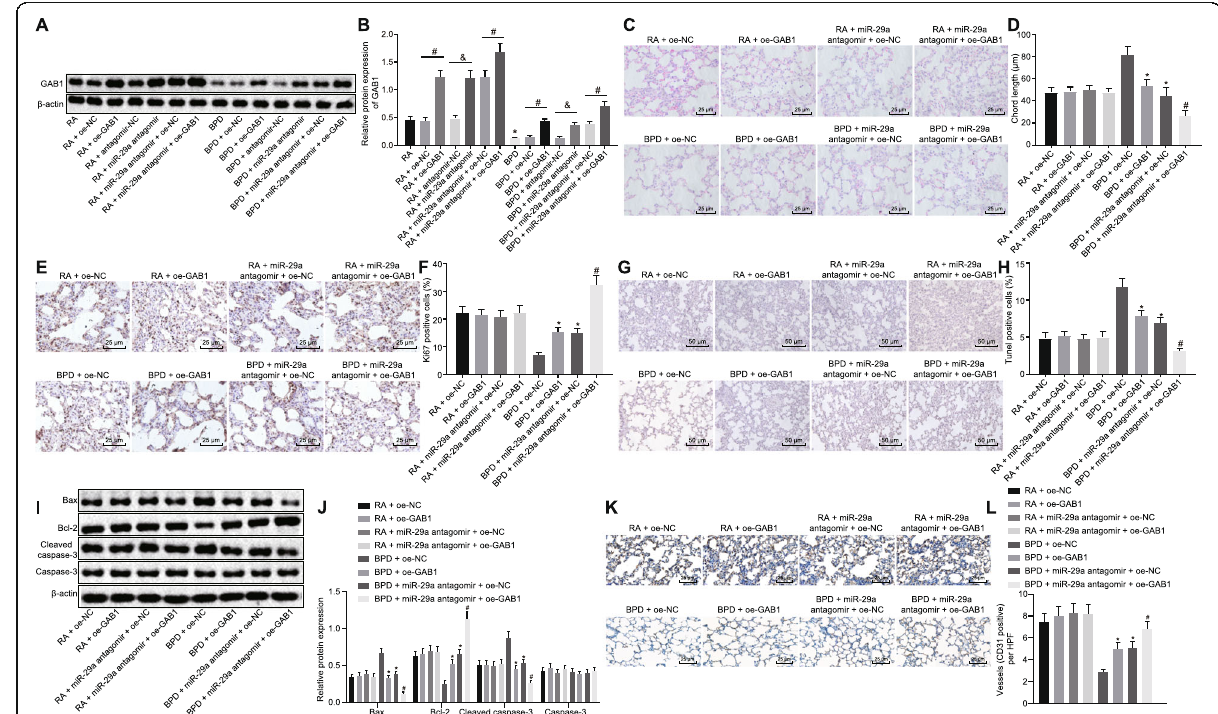
Fig. 4 Upregulation of GAB1 ameliorates BPD in neonatal mice. A&B, Western blot analysis of GAB1 protein in lung tissues of each group. * p < 0.05 vs. neonatal mice under RA exposure (the RA group). # p < 0.05 vs. neonatal mice with hyperoxia-induced BPD receiving oe-NC vector injection (the BPD + oe-NC group). & p < 0.05 vs. neonatal mice with hyperoxia-induced BPD receiving antagomir-NC injection (the BPD + antagomir-NC group). C, HE staining analysis of lung tissues in each group (× 400). D, Alveolar chord length of lung tissues in each group. E&F, Positive expression level of Ki67 in lung tissues of each group determined by immunohistochemistry (× 400). G&H, Cell apoptosis in lung tissues of each group assessed by TUNEL staining (× 200). I&J, Western blot analysis of apoptosis-related proteins (Bax, Caspase-3 and Bcl-2) in lung tissues of each group. K&L, Positive expression rate of CD31 protein in lung tissues of each group determined by immunohistochemistry (× 400). In panel C-L, * p < 0.05 vs. neonatal mice with hyperoxia-induced BPD receiving oe-NC vector injection (the BPD + oe-NC group). # p < 0.05 vs. neonatal mice with hyperoxia-induced BPD receiving an injection of antagomir-NC combined with oe-NC vector (the BPD + antagomir-NC + oe- NC group). N = 15. Measurement data were expressed as mean ± standard error. Data comparison between two groups was examined by unpaired t -test. miR-29a, microRNA-29a; GAB1, GRB2-associated-binding protein 1; BPD, bronchopulmonary dysplasia; RA, room air; Bax, Bcl-2- associated X protein; Bcl-2, B-cell lymphoma 2; HE, hematoxylin-eosin; RAC, radial alveolar counts; TUNEL, TdT-mediated dUTP-biotin nick